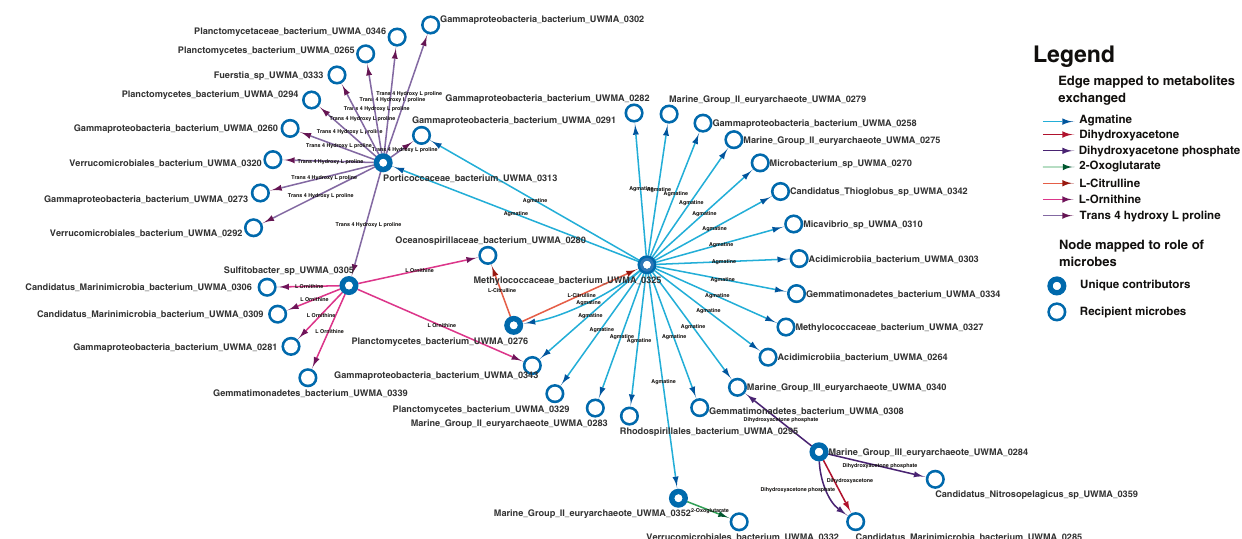
Fig. 6 Unique microbial contributors in all-media. This network highlights the unique contributors to the Guaymas microbiome in all-media. Each node represents a microbe, and the arrows start from donating the microbe to the recipient microbe. The colour of the arrows is mapped to different unique metabolites exchanged by the unique